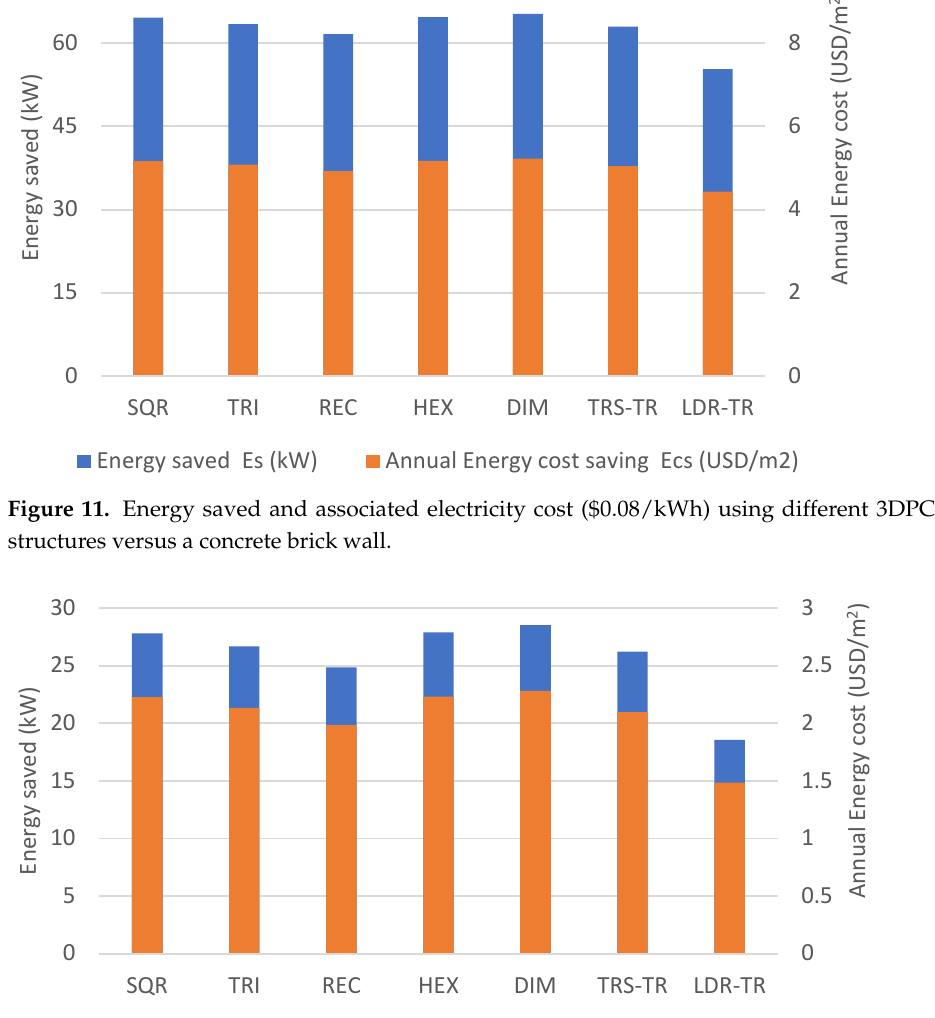
Figure 13. Energy saved and associated electricity cost reduction ($0.08/kWh) using different 3DPC infill structures versus an insulated red brick wall. Table 5 summarizes the amount of energy saved and the annual energy cost savings for the different 3DPC infill structures compared with the three conventional walls, i.e., concrete brick walls, red clay brick walls, and insulated red clay brick walls. In this table, the electricity rating considered for electricity cost reduction is 0.08 USD/kWh. The table shows as high as 5 USD/m 2 in annual electricity bill savings. However, further detailed studies are required to include the initial cost and provide clarification on overall building life cycle costing. Nevertheless, the current economic evaluation reveals that the future of